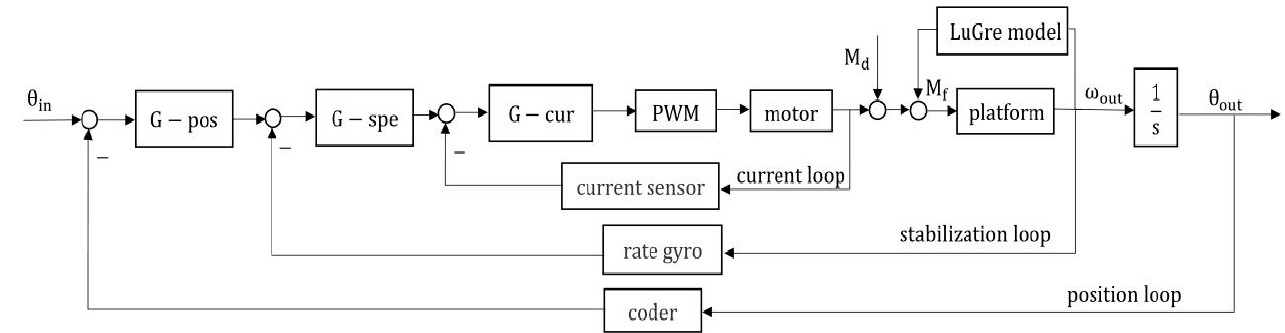
Figure 2. Block diagram of three closed-loop control system for